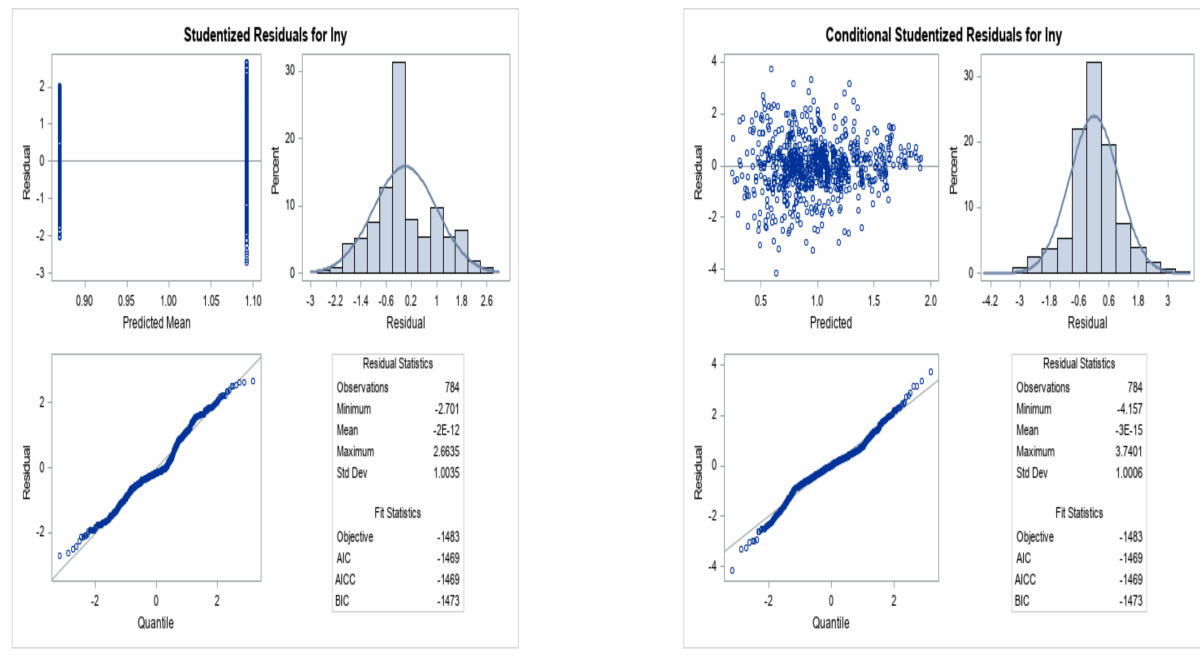
Figure 3. Marginal and conditional Studentized residual for grain yield (in log scale). Given the random effects, the conditional the Studentized residual for grain yield represents the difference between the observed and predicted values. The scatter plot depicts the conditional residuals’ homoscedasticity. The residual statistics are shown in the lower right, with the mean of the residual being zero and the standard deviation being one. The residual versus predicted value of the conditional is represented by the left top plot. The Studentized residual indicates the homoscedasticity of the conditional error, and the histogram and Q-Q plot of the residual show that the conditional residual meets the normality assumption (Figure